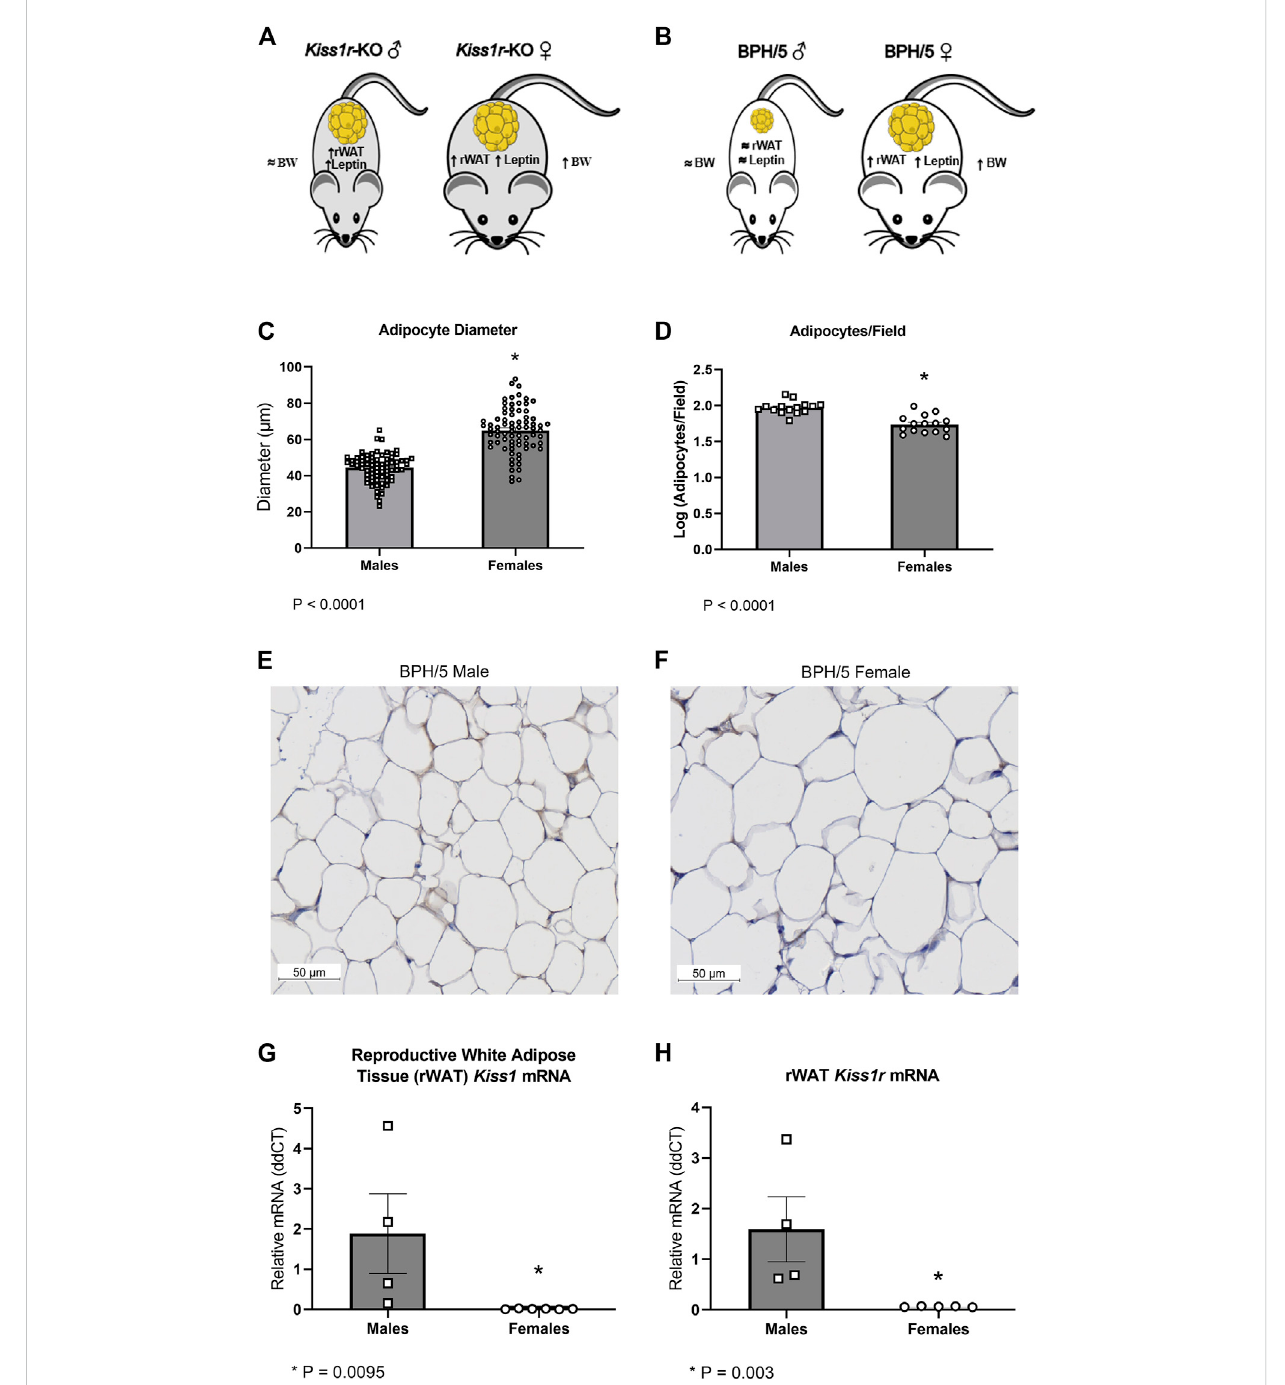
Sexually dimorphic adipocyte hypertrophy and altered kisspeptin/receptor expression occurs in reproductive white adipose tissue of adult BPH/ 5offspring. (A) Previouslydescribedsexuallydimorphicmetabolicphenotypeglobal Kiss1r knockout(KO)mice(Tolsonetal.,2014;Tolsonetal.,2016). (B) Sexually dimorphic metabolic phenotype of adult BPH/5 offspring. (C) Average adipocyte diameter (µm) in the reproductive white adipose tissue (rWAT) ofBPH/5malesandBPH/5females( n =75adipocytes/group,Student ’ st-test,mean±SEM,* p < 0.0001). (D) Numberofadipocytespermicroscopic fi eld in the rWAT of adult BPH/5 males and females ( n = 15 fi elds/group, Student ’ s t-test, mean ± SEM, * p < 0.0001). (E,F) Representative photomicrographsofrWAT ofadult (E) BPH/5males and (F) BPH/5 females(scalebar=50 µm). (G) Kiss1 relativemRNAexpressioninrWAT ofadultBPH/ 5 males and females ( n = 4 – 6/group, Student ’ s t-test, mean ± SEM, * p = 0.0095). (H) Kiss1r relative mRNA expression in rWAT of adult BPH/5 males and females ( n = 4 – 6/group, Student ’ s t-test, mean ± SEM, * p =